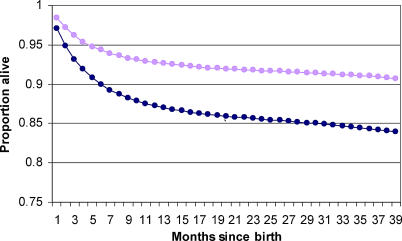
Model of Risk of Death over Time by Water AccessData presented are controlled for sex, preceding interval length, mother's age, parity, religion, socioeconomic status, and village for 2,914 births. Purple curve, access to taps; blue curve, no access to taps.